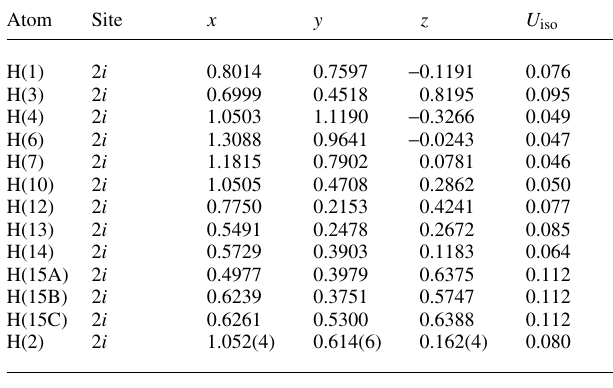
Table 2. Atomic coordinates and displacement parameters (in Å 2 )